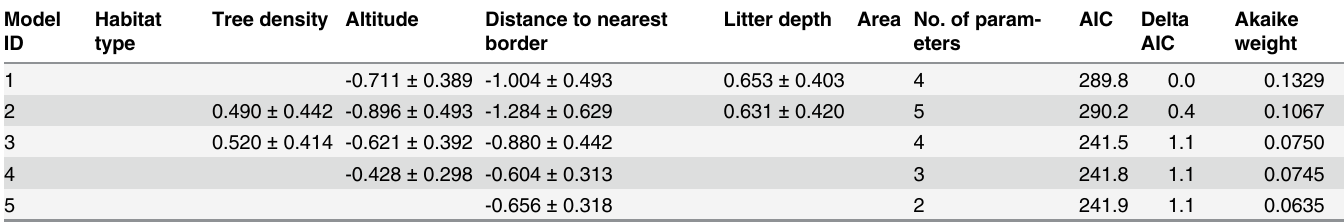
Table 5. Top 5 competing AIC models competing for first rank. Beta coefficients ± standard errors for each covariate are